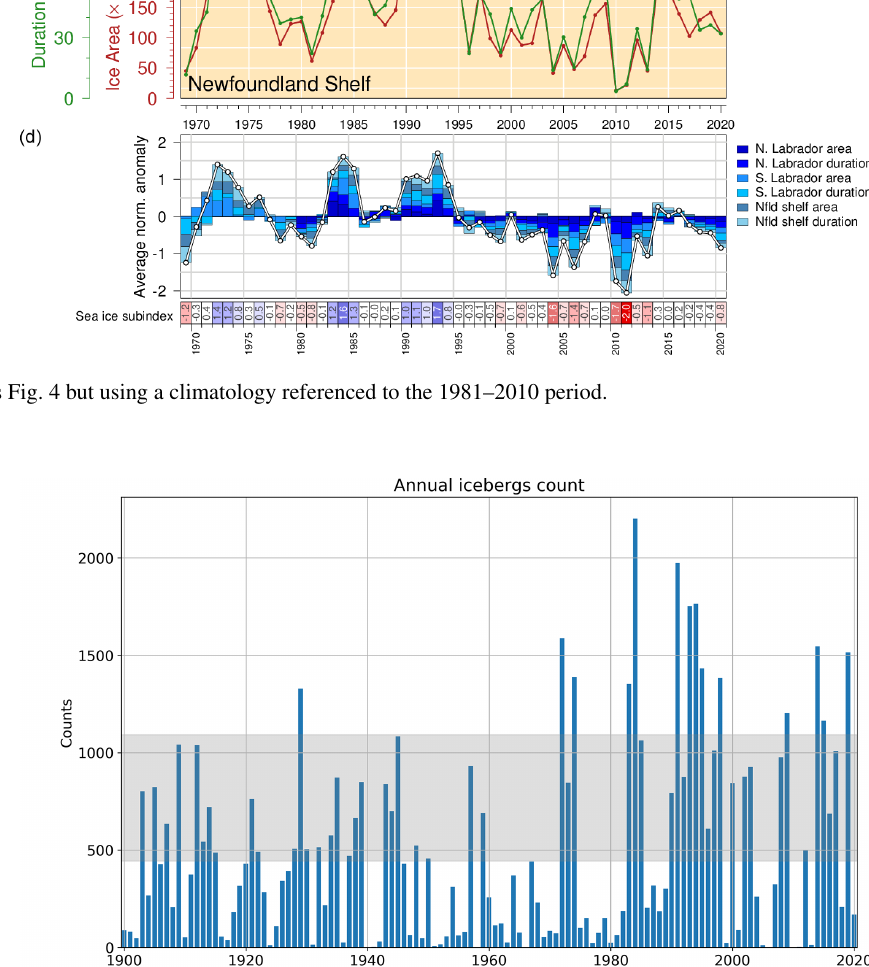
Earth Syst. Sci. Data, 13, 1807–1828,